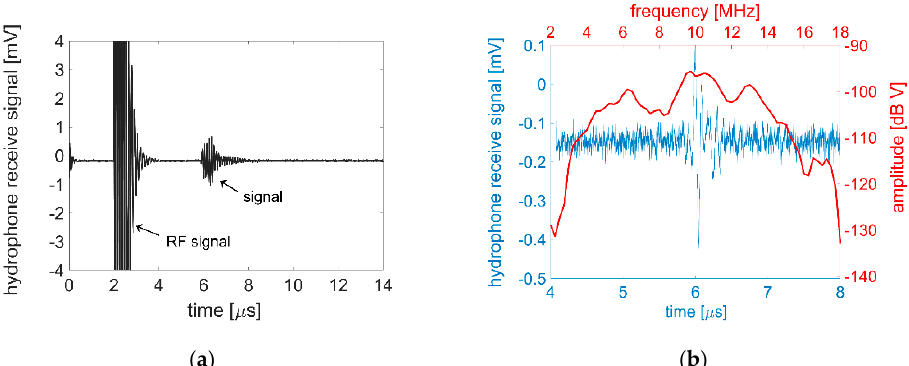
Figure 5. (a) Hydrophone characterization of a 100 µm × 1000 µm single element driven with a 5 V unipolar sinusoidal excitation at 9.5 MHz. The detected 1.6 mV corresponds to a 33 kPa sound pressure output; ( b ) Hydrophone detection of a single cycle excitation along with FFT calculation, which shows a − 6 dB bandwidth of ~32%.